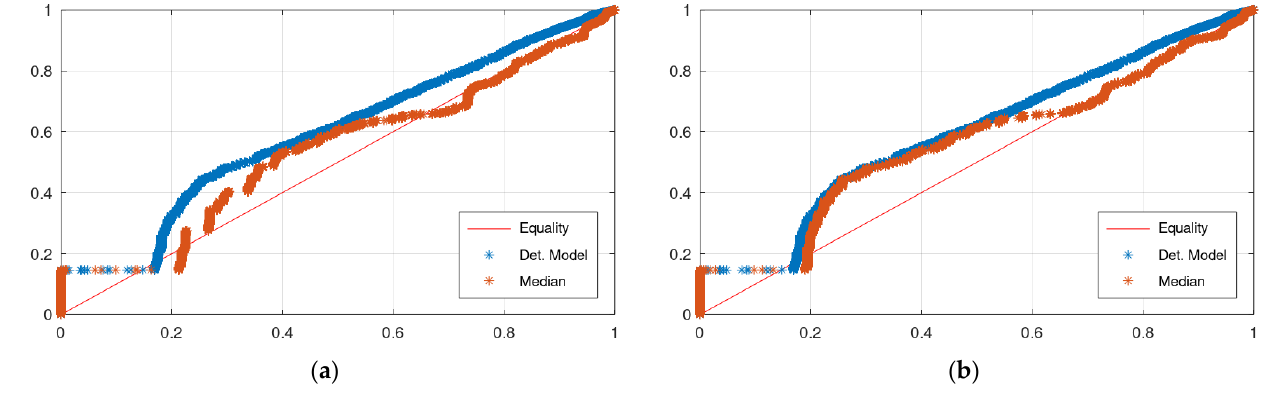
Figure 7. CPP plots of the Sieve River case study: ( a ) KNN; ( b ) Bluecat. “Det. Model” is the simula- tion with HyMod.